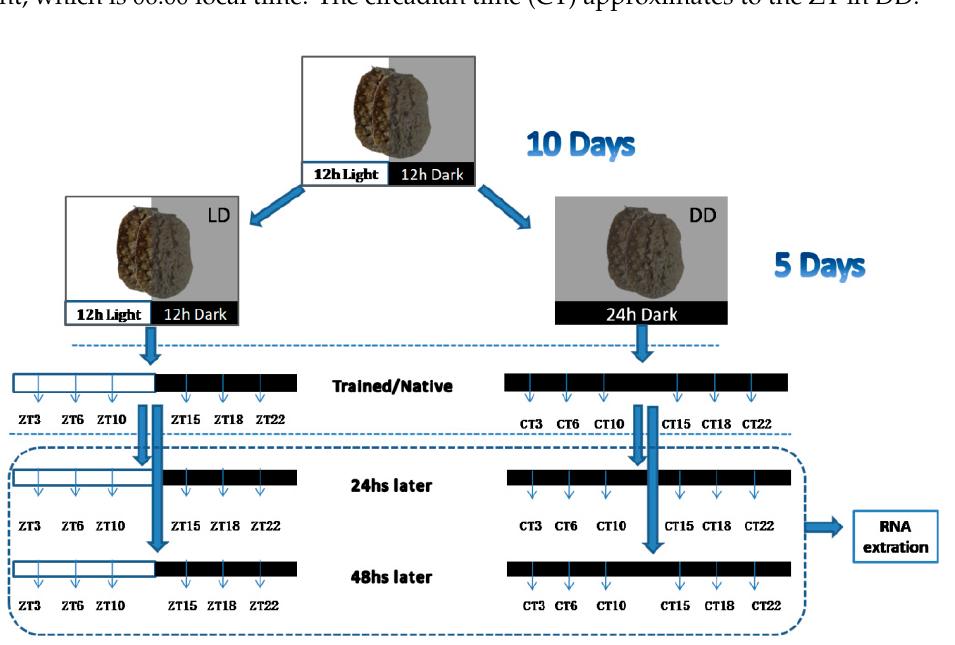
Figure 1: Experimental procedure for the whole experiment. A total of 216 animals were used in these experiments. Animals were trained at ZT/CT 3, 6, 10, 15, 18, and 22 after five-day treatment in an LD/DD cycle. After 24 and 48 h, all trained animals were tested at the same time points (ZT/CT 3, 6, 10, 15, 18, and 22). N = 6 for every time point in the behavioral experiment and n = 3 for every time point in the molecular experiment. ZT: zeitgeber time, CT: circadian time, LD: light–dark, DD: dark–dark.